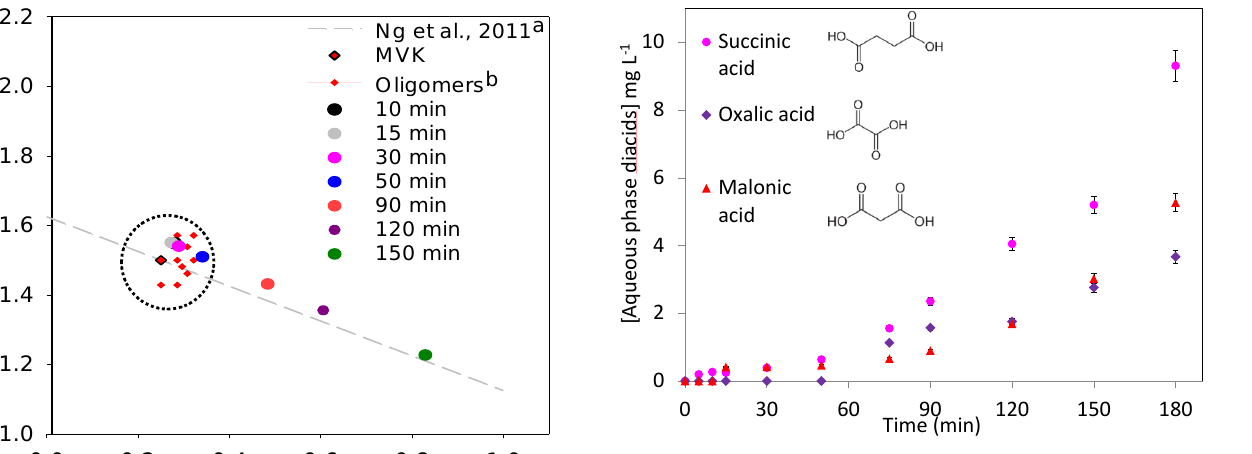
Figure 10. Time profiles of the quantified diacids in the solutions as measured by IC-ESI-MS for experiment B ([MVK]0 =